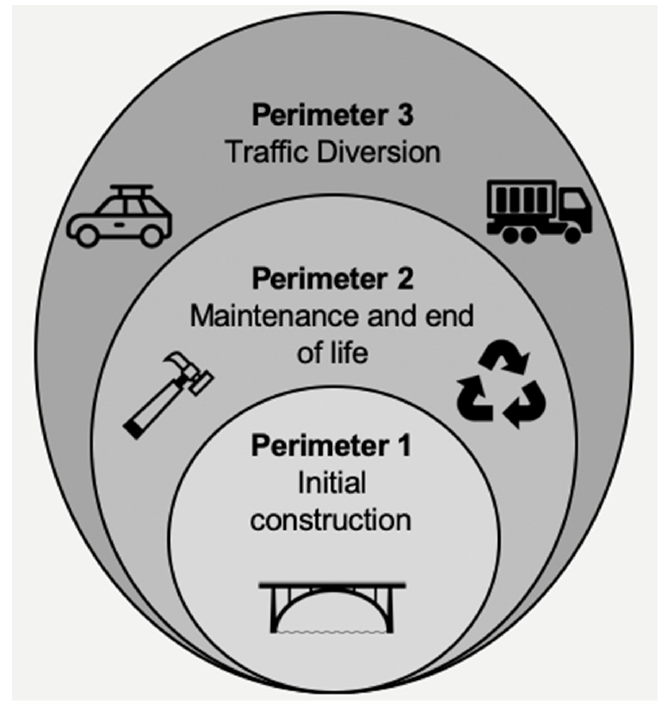
Figure 7. Definition of the studied